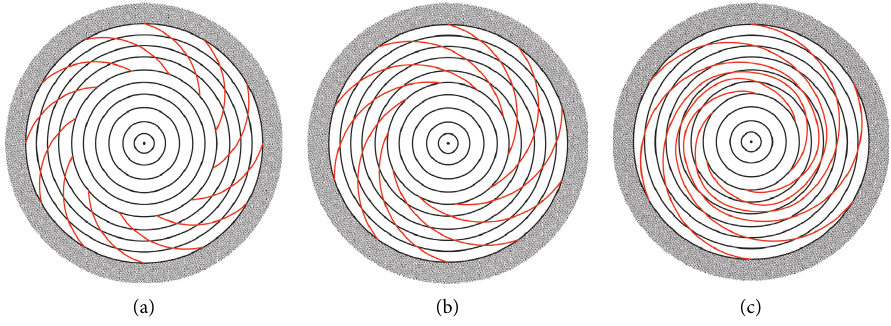
Figure 5: Bottom-hole patterns under different deviation angles.